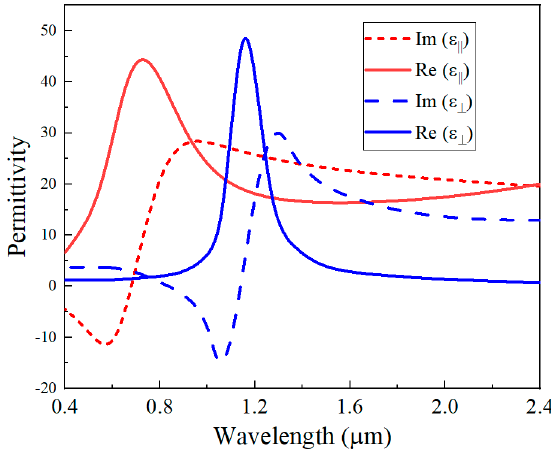
Figure 2. Imaginary and real parts of relative permittivity retrieved from generalized spectroscopic ellipsometry measurements of Bi 2 Se 3 with ac -facet and ab -facet.